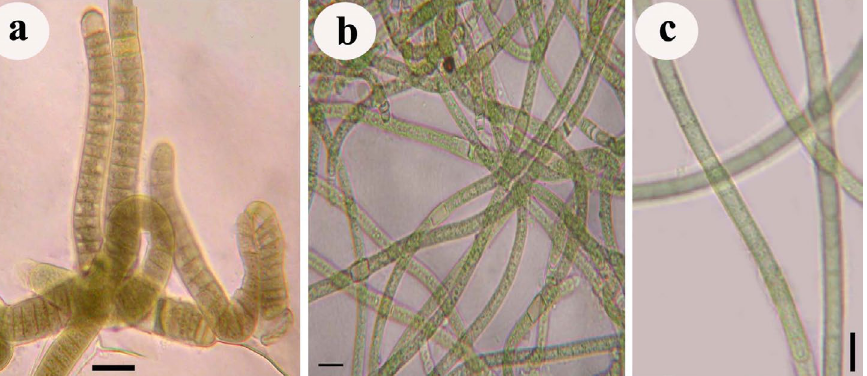
Fig. 8. Photograph showing three different sub-aerial cyanobacteria species isolates, a. Scytonema coactile (blackish- brown crust on the limestone surface in the twilight zone of Gupteswar cave), b. Scytonema geitleri (blackish crust on the lime-washed building facade) and c. Lyngbya aerugineo - coerulea (brownish crust on the stone surface of Bhaskareswar temple)from the eastern region of